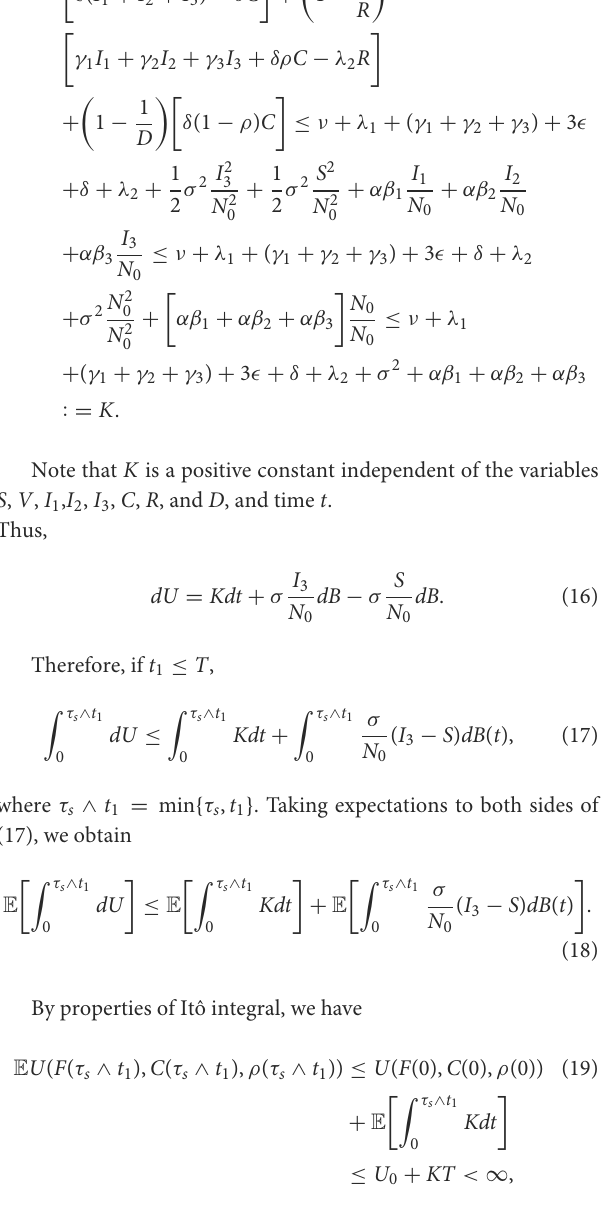
TABLE 2 Values of the parameters used in the simulations.